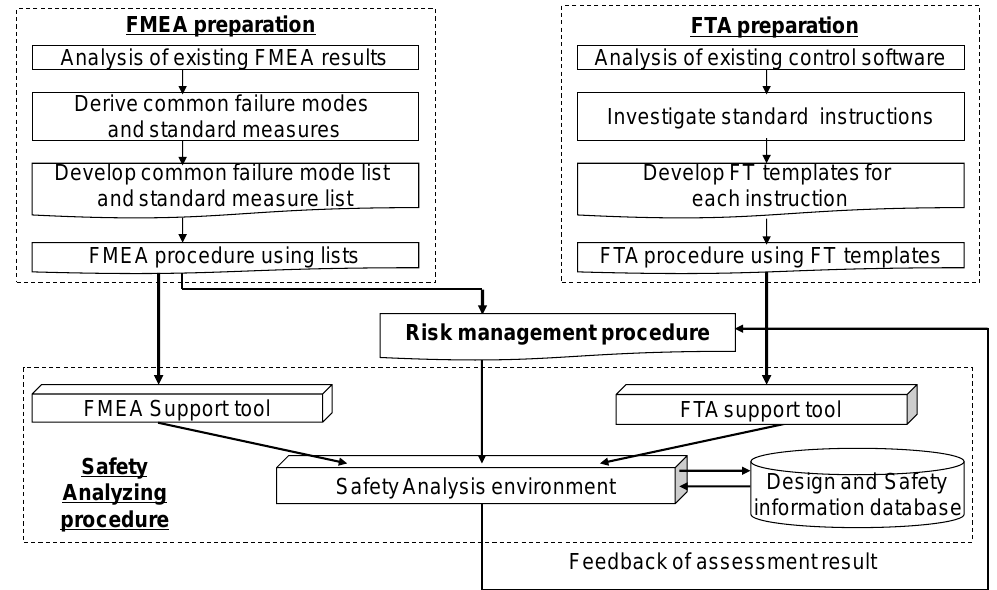
Figure 8. Outline of the proposed safety analysis support environment.